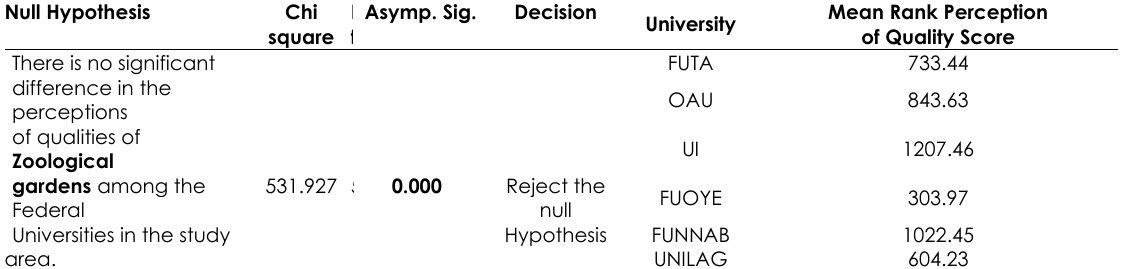
Table 3. Kruskal Wallis H Test of significant difference in the perceptions of qualities of theUniversity Zoological gardens in South- west Nigeria. Null Hypothesis